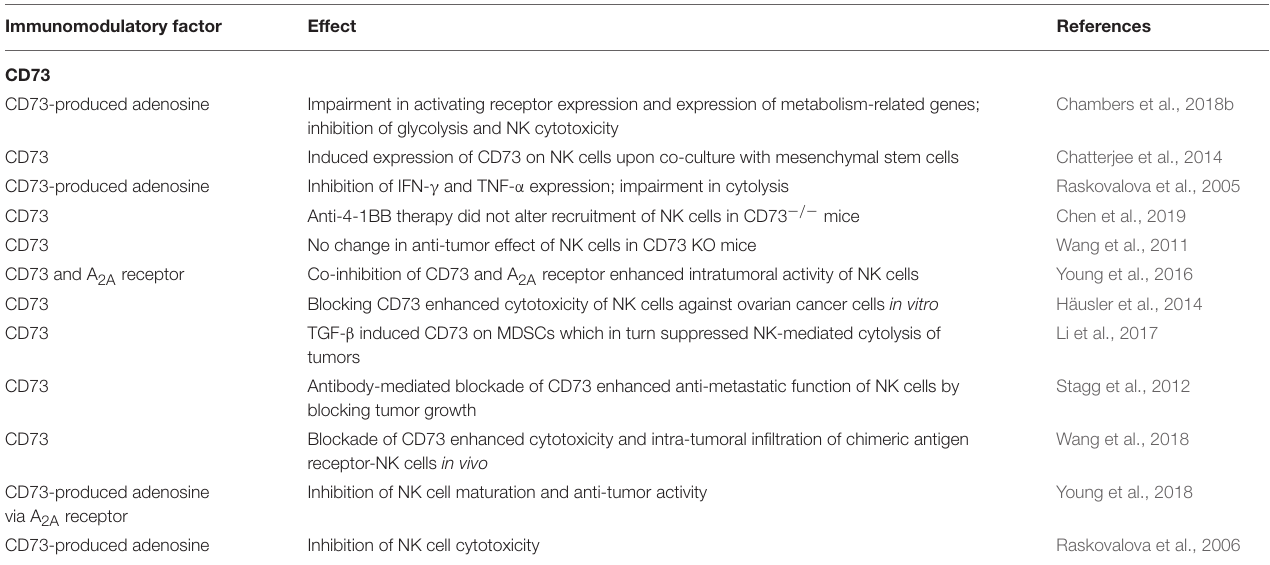
TABLE 2 | Effects of CD73 on NK cell function and